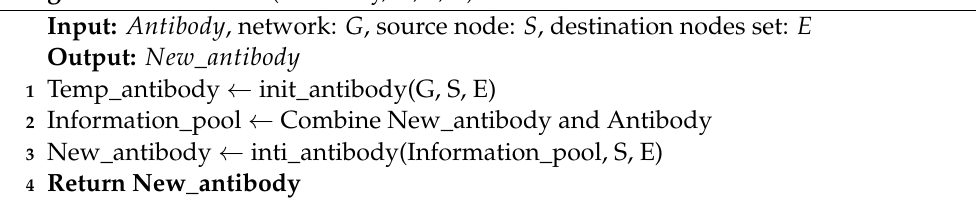
Algorithm 6: mutation(Antibody, G, S, E)